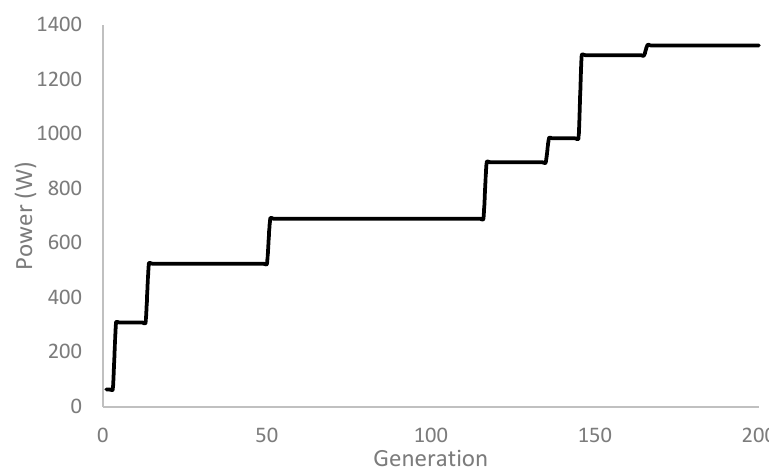
Figure 4. Optimal value of output power for each generation.